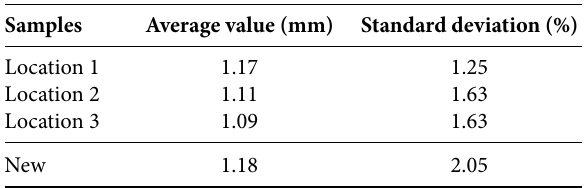
Table 6. Thickness of the new and aged membranes.